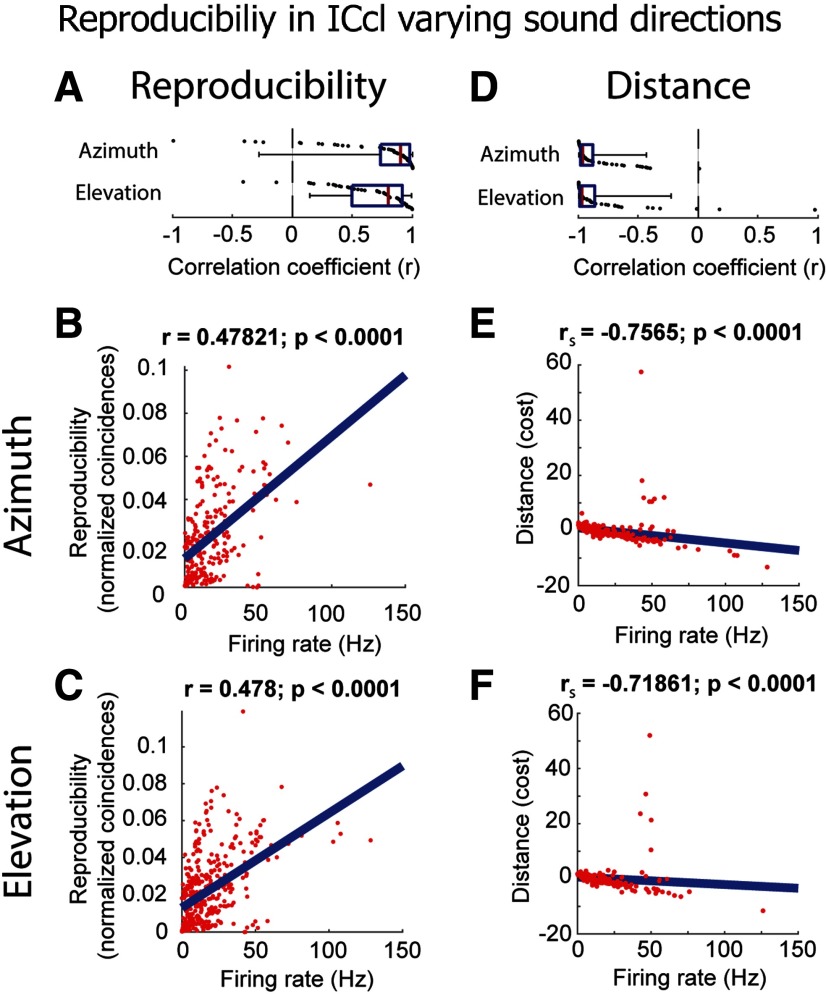
Relationship between reproducibility and firing rate in ICcl (N = 64), varying spatial location in free field (same format as in Fig. 4). A, Correlation coefficients (r) of reproducibility against firing rate for each neuron for varying azimuth (top) and elevation (bottom). B, C, Reproducibility as a function of firing rate for all neurons for varying azimuth (B) and elevation (C). Firing rates and reproducibility are normalized by the maximum and minimum for each neuron. D–F, Same description as for A–C but for the corrected Victor–Purpura distance metric.